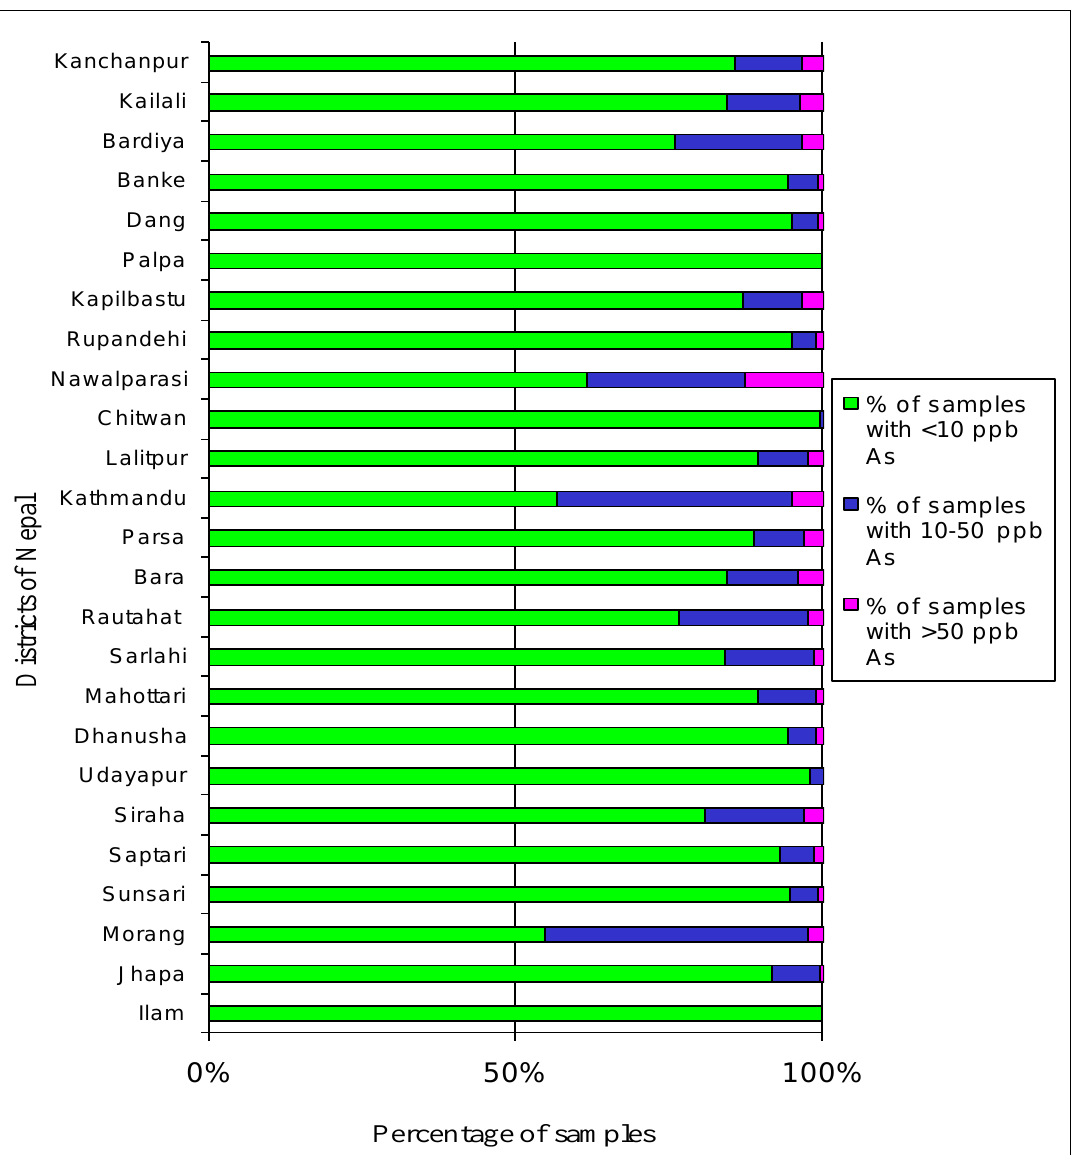
Figure 5. Percentage of arsenic contaminated samples in various districts of Nepal.